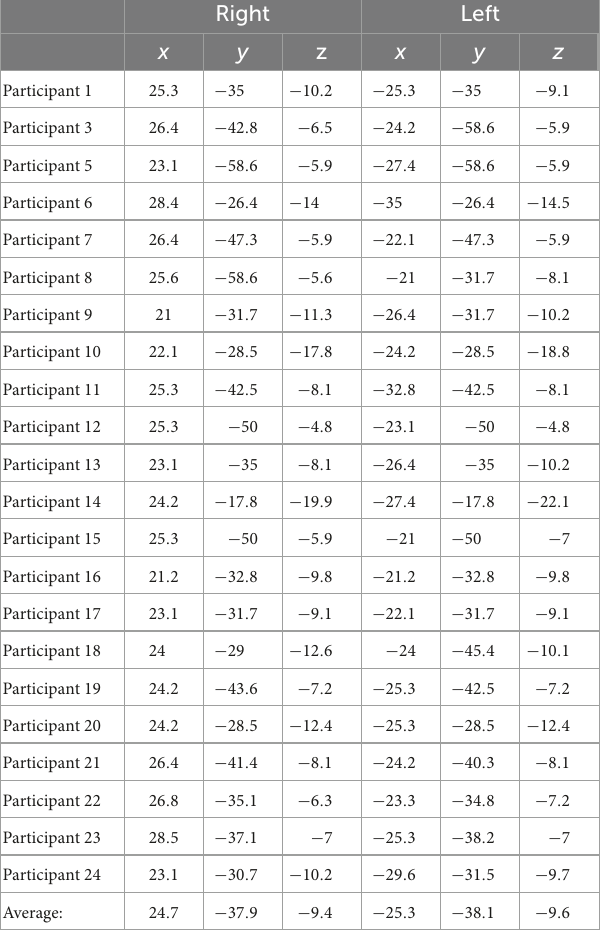
TABLE 4 Individual Talairach coordinates (mm) of functional magnetic resonance imaging (fMRI)-weighted dipole fits for the encoding